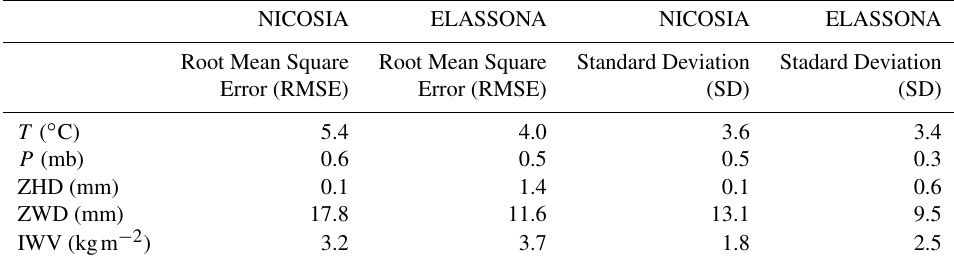
Table 2. The RMSE of absolute bias and Standard Deviations (a) between in situ meteorological observations and ECMWF (IFS) model values of T , P and (b) between parameters (ZHD, ZWD, IWV) obtained by using ECMWF (IFS) model and the respective ones retrieved from GNSS observations by using T , P obtained from in situ meteorological stations, for both stations during the period of